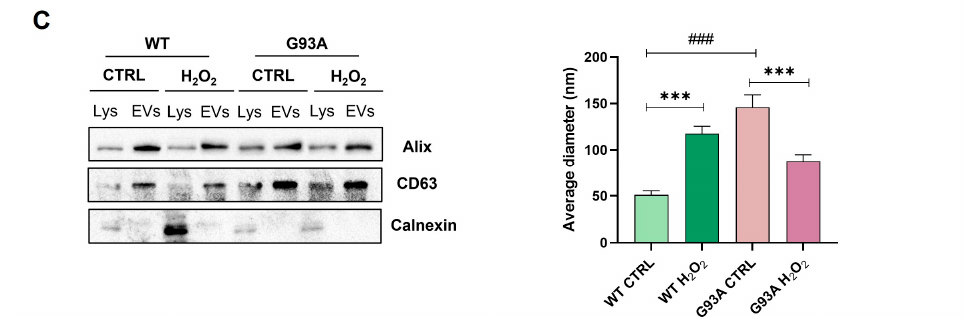
Figure 2. Morphological and quantitative characterization of extracellular vesicles released from untreated and H 2 O 2 -treated WT and SOD1-G93A SH-SY5Y cells. ( A ) TEM analysis of EVs released from SH-SY5Y WT and SOD1-G93A cells, untreated (control) or treated with H 2 O 2 100 µ M. Scale bars = 100 nm. ( B ) Size distribution and average diameter of the EVs from all experimental groups, Ntot = 59, 47, 43, and 47. Values represent the mean ± SD; statistical analysis was carried out using one-way ANOVA with Tukey’s multiple comparisons test. *** p < 0.001, when compared with the control group; ### p < 0.001, when compared between WT and G93A groups. Lys = cell lysates. ( C ) Alix, CD63, and Calnexin protein expression from SH-SY5Y WT and SOD1-G93A cells, untreated (control) or treated with H 2 O 2 100 µ M, performed by Western